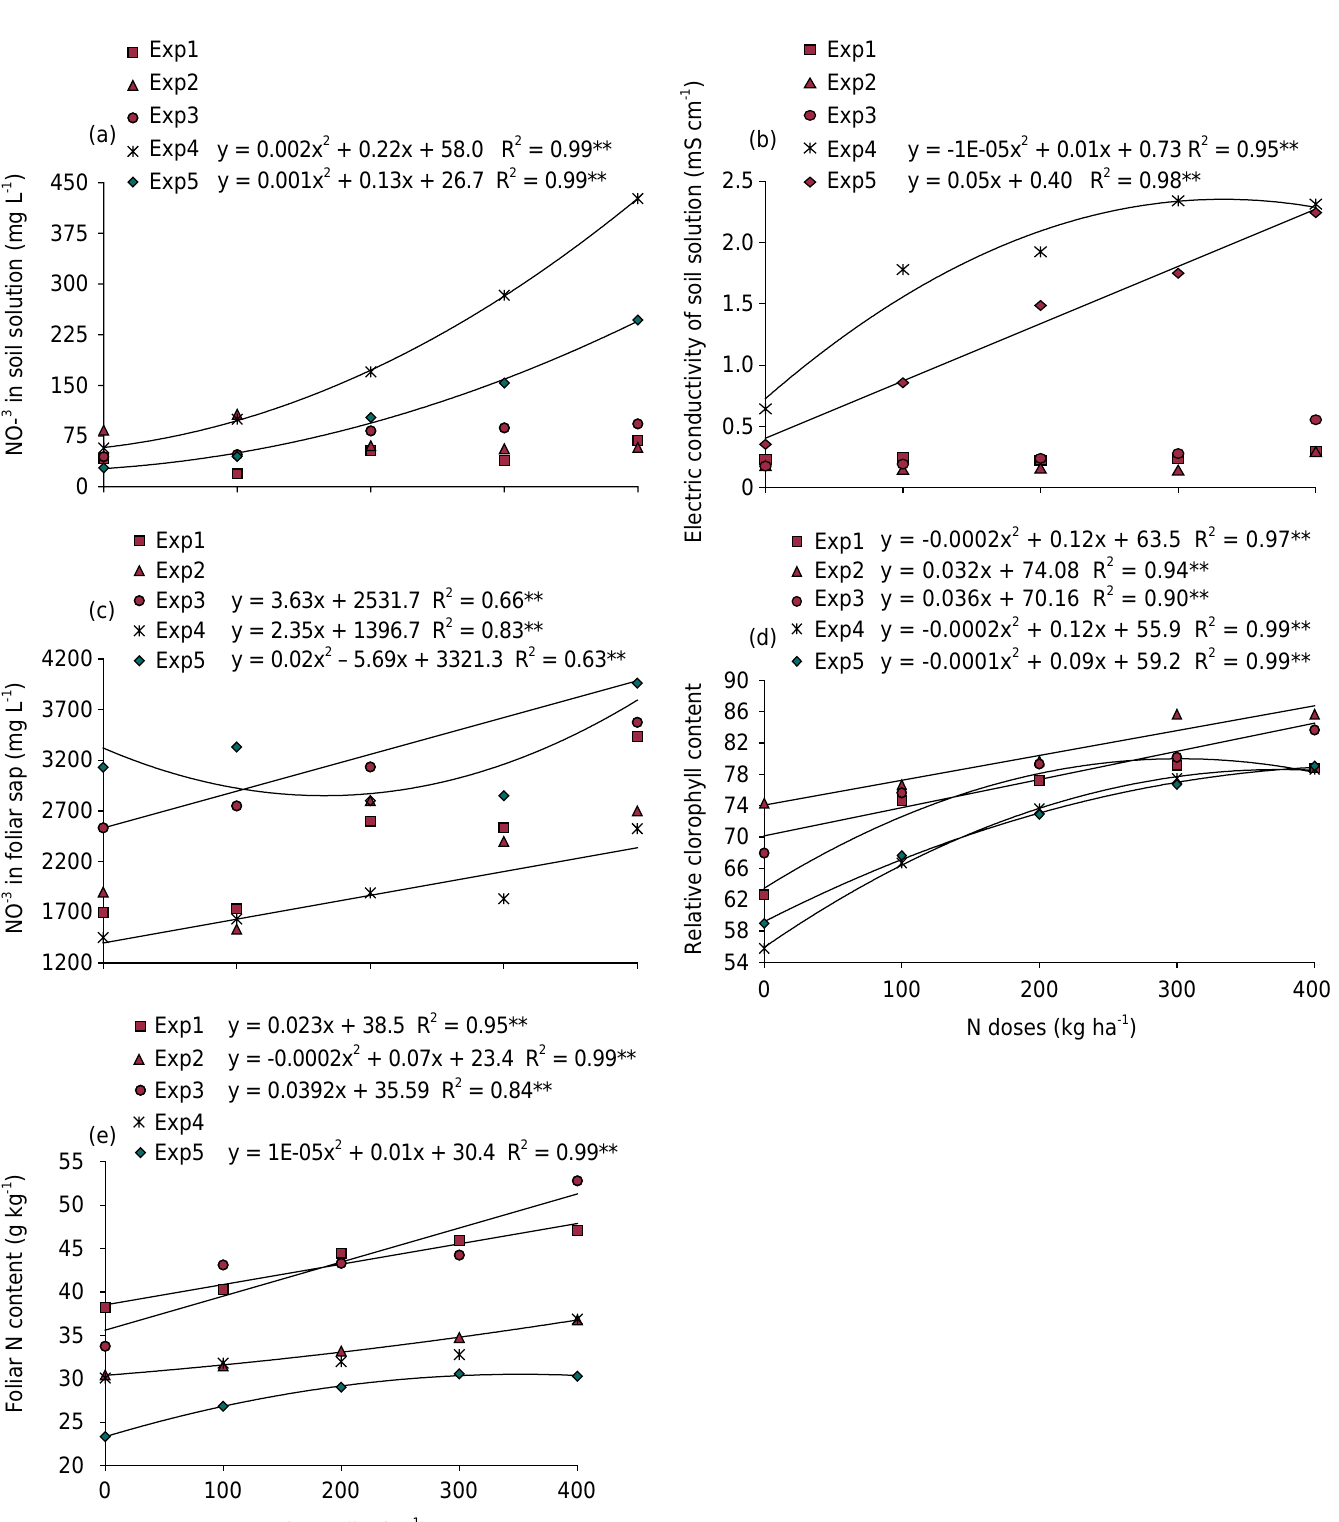
Figure 2. Nitrate levels (NO 3- ) (a), electrical conductivity of the soil solution (b), nitrate levels in foliar sap (c), relative chlorophyll content (d), and foliar N content (e) as a function of the application of increasing doses of N in five experiments of virus-free garlic. * , ** : significant at 5 and 1 %